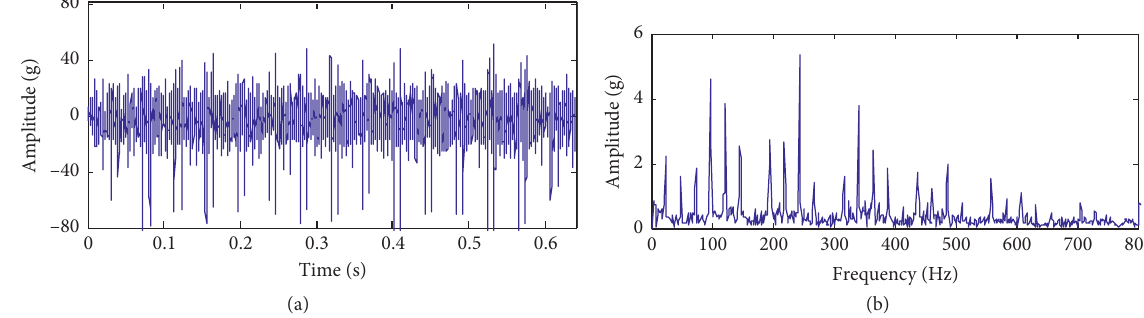
Figure 14: Comparison results of experimental signal by the MCKD method: (a) the waveform of deconvolution signal; (b) the envelope spectrum of deconvolution signal.